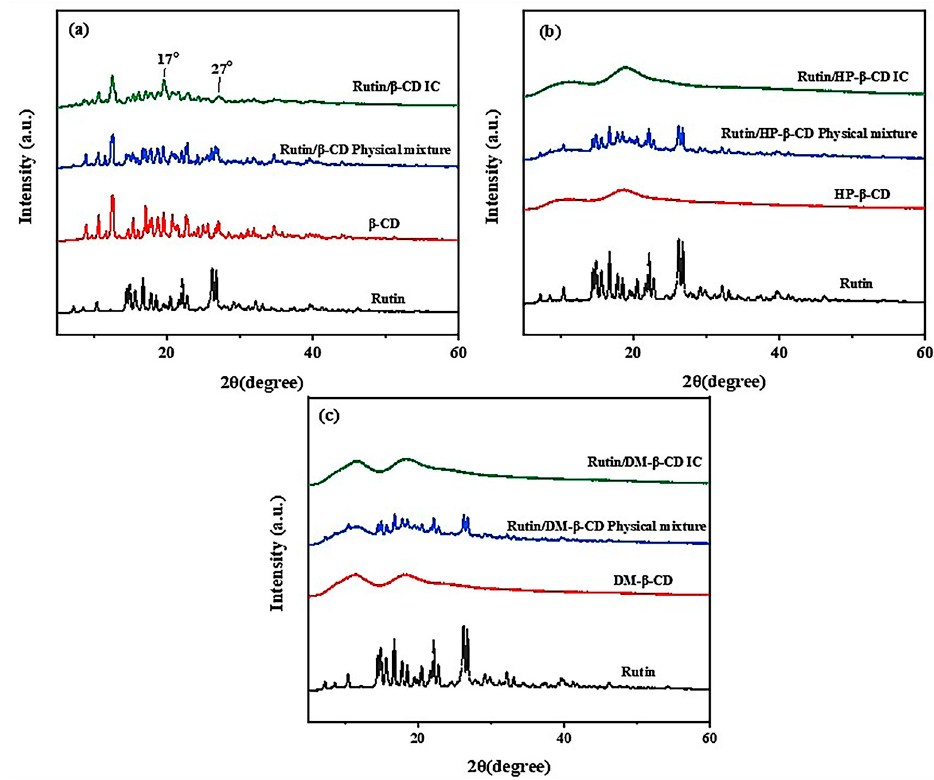
Figure 3. X-ray diffractometry spectra of ( a ) rutin, β -CD, rutin/ β -CD physical mixture, rutin/ β -CD IC; ( b ) rutin, HP- β -CD, rutin/HP- β -CD physical mixture, rutin/HP- β -CD IC; ( c ) rutin, DM- β -CD, rutin/DM- β -CD physical mixture and rutin/DM- β -CD IC.